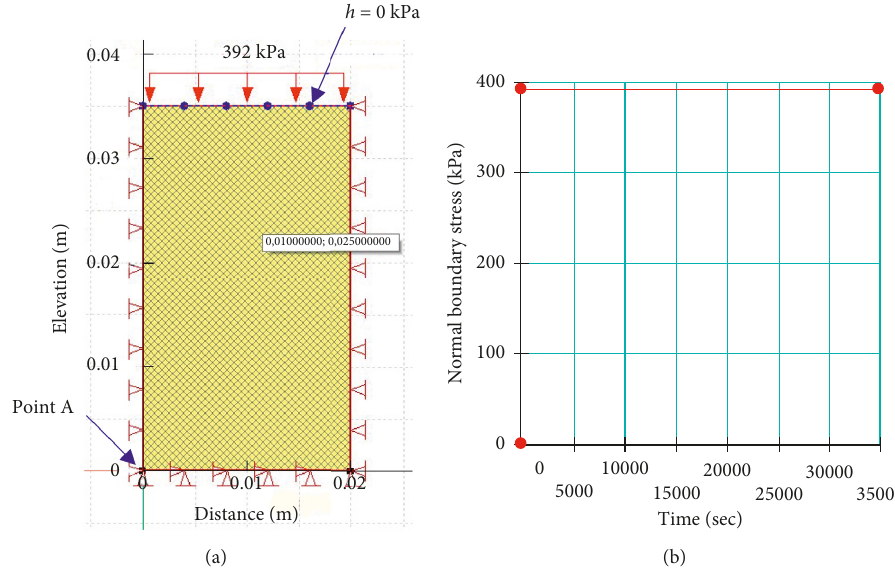
Figure 18: (a) The numerical model of the clay cylinder, built with SIGMA/W after considering the axis-symmetry; (b) loading function applied in the numerical model.